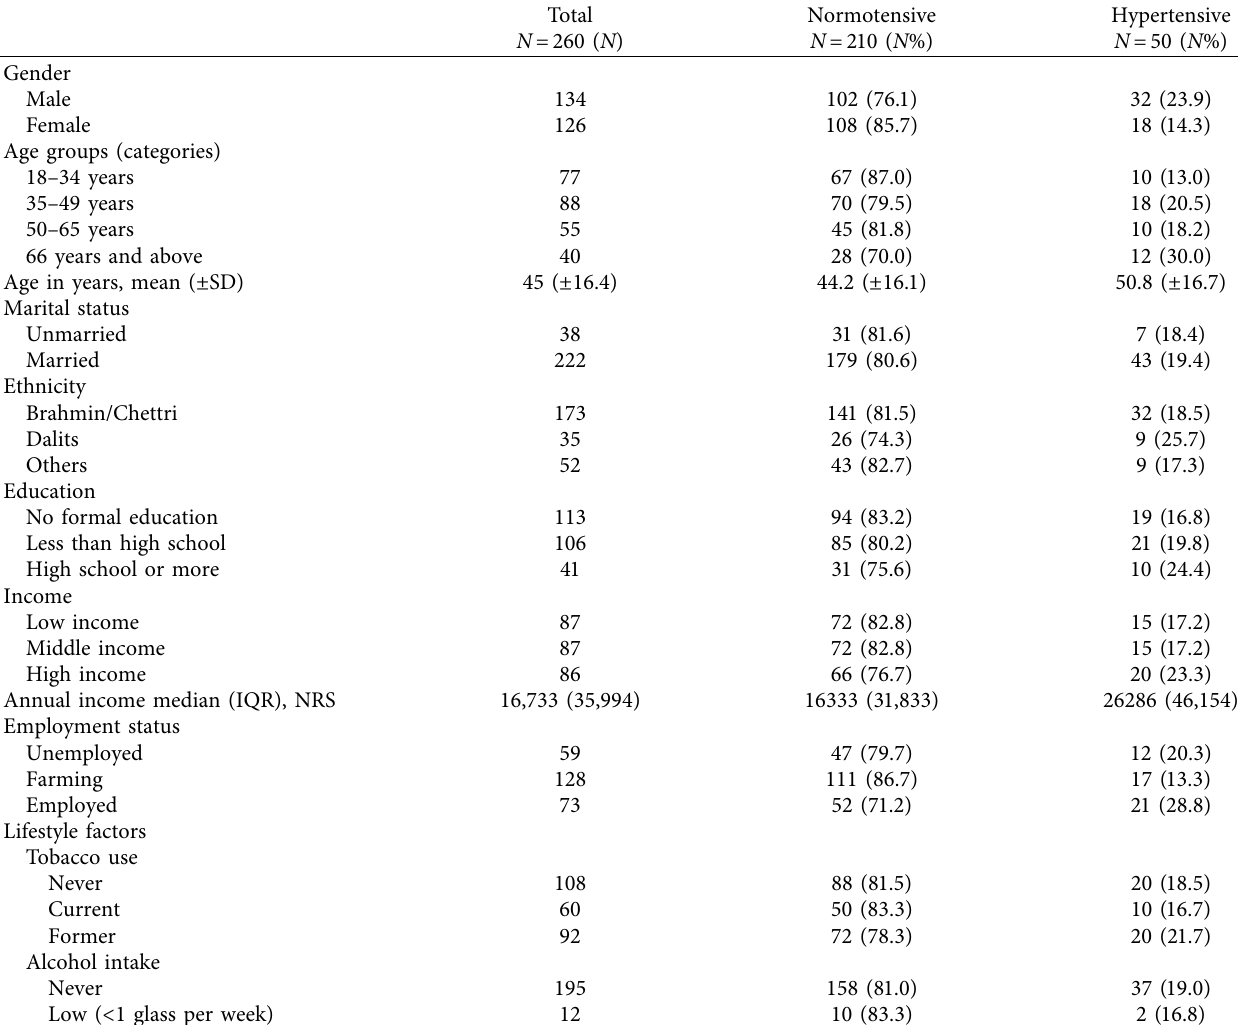
Table 1: Distribution of sociodemographic, lifestyle, and SES factors by hypertension status.